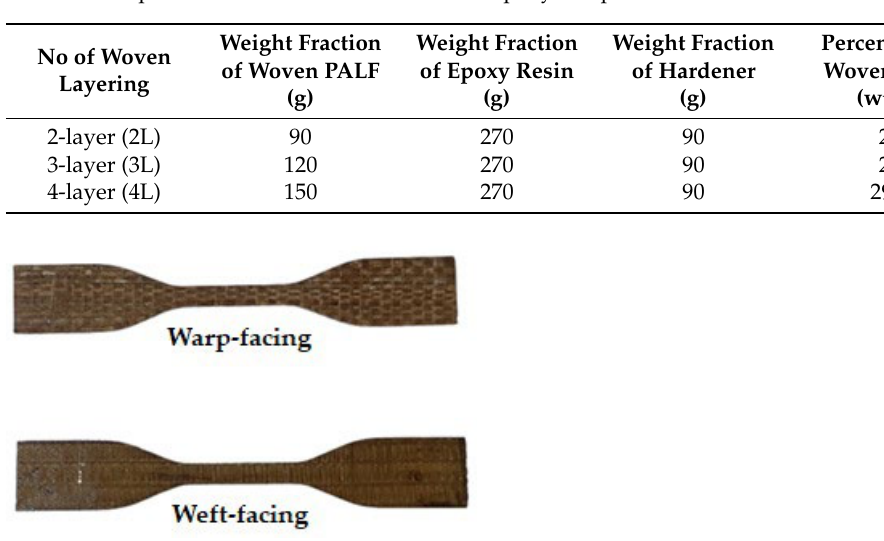
Table 1. Composition of woven PALF-reinforced epoxy composite.